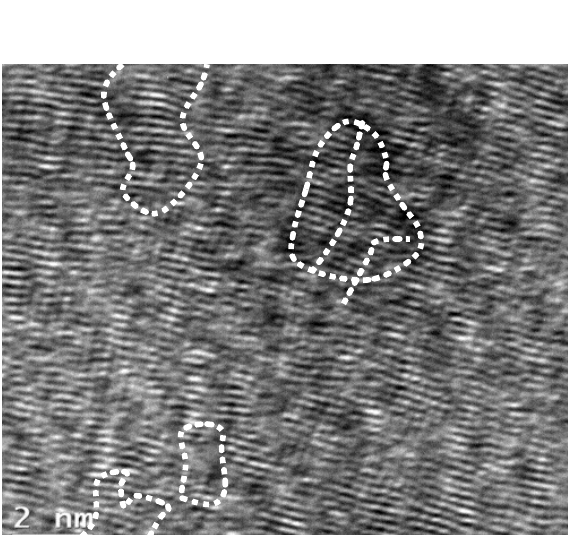
Figure 5. Structure of the reactive HiTUS TiNbVTaZrHf-xN coating deposited with 2 sccm N 2 : ( a ) low magnification TEM image; ( b ) HRTEM images and the corresponding SAED with azimuthal integral SAED; ( c ) Fast Fourier transformation (FFT) enhanced cut-off with possible boundaries between selected and highly defect crystalline domains.